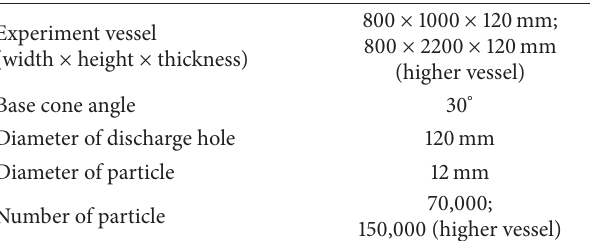
Table 1: Main parameters of experimental